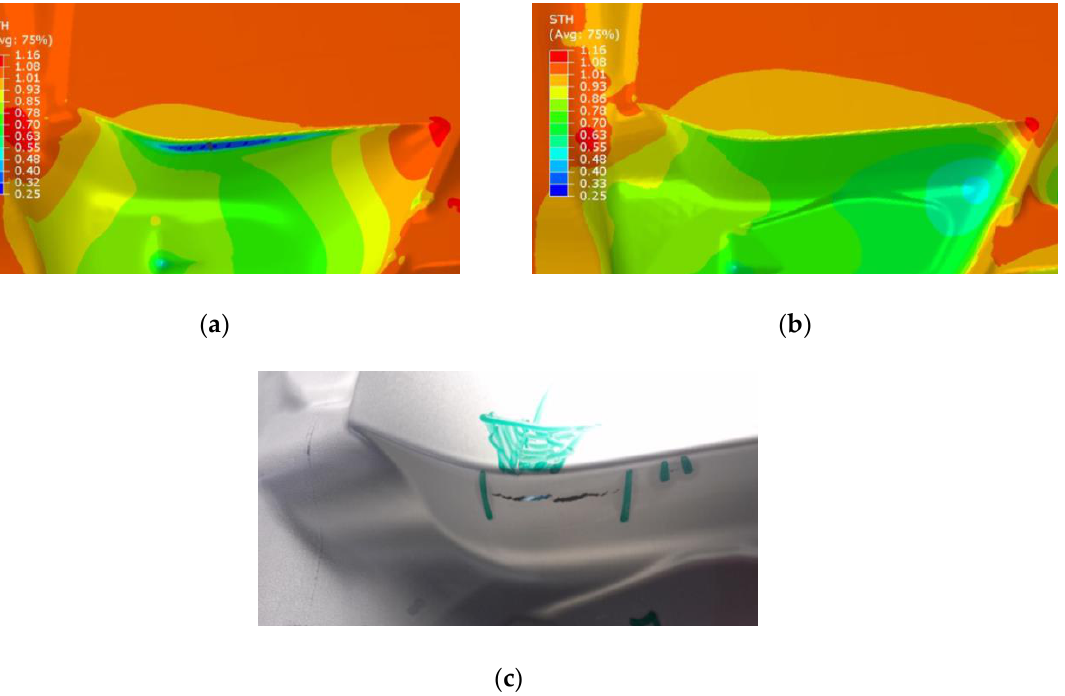
Figure 12. The part deformed with gas profile #1 ( t : 80 s): ( a ) FE prediction using VmV model; ( b ) FE prediction using power law; and ( c ) the observed crack.